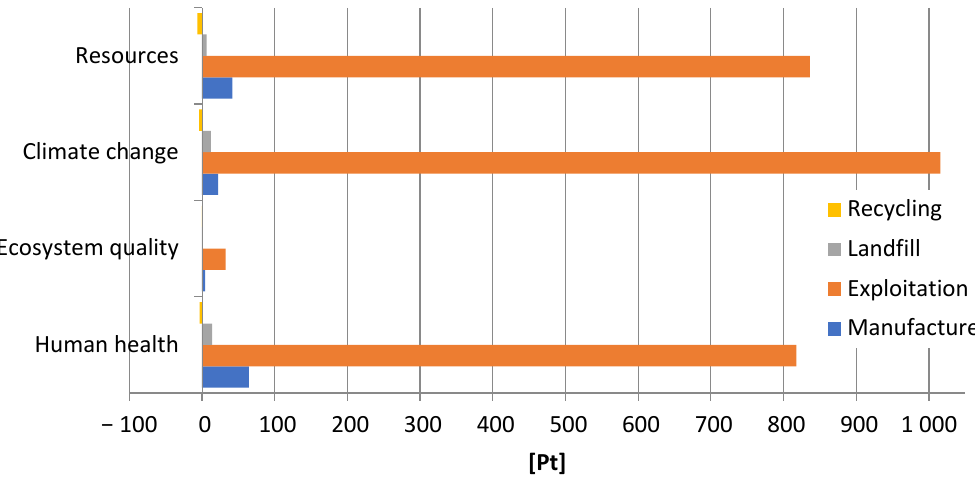
Figure 19. The results of grouping and weighing the environmental consequences occurring at individual stages of the life cycle of the research object by areas of influence.